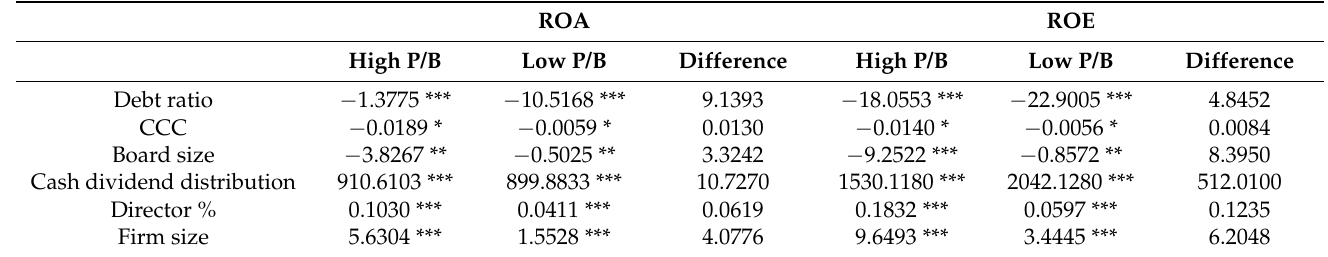
Table 3. Regression results with a separate P/B ratio.